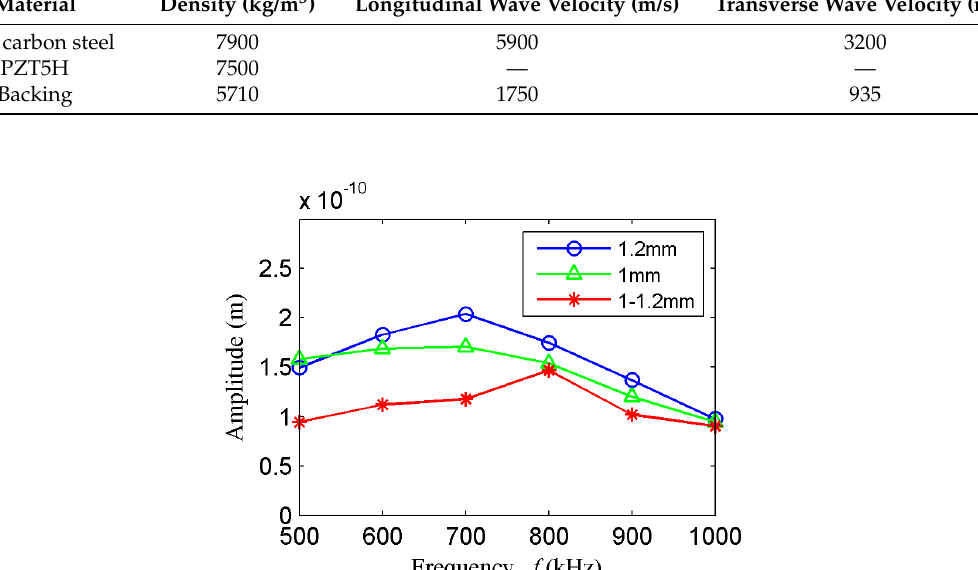
Figure 8. Rayleigh wave amplitude comparison of the comb transducer with different element thickness.